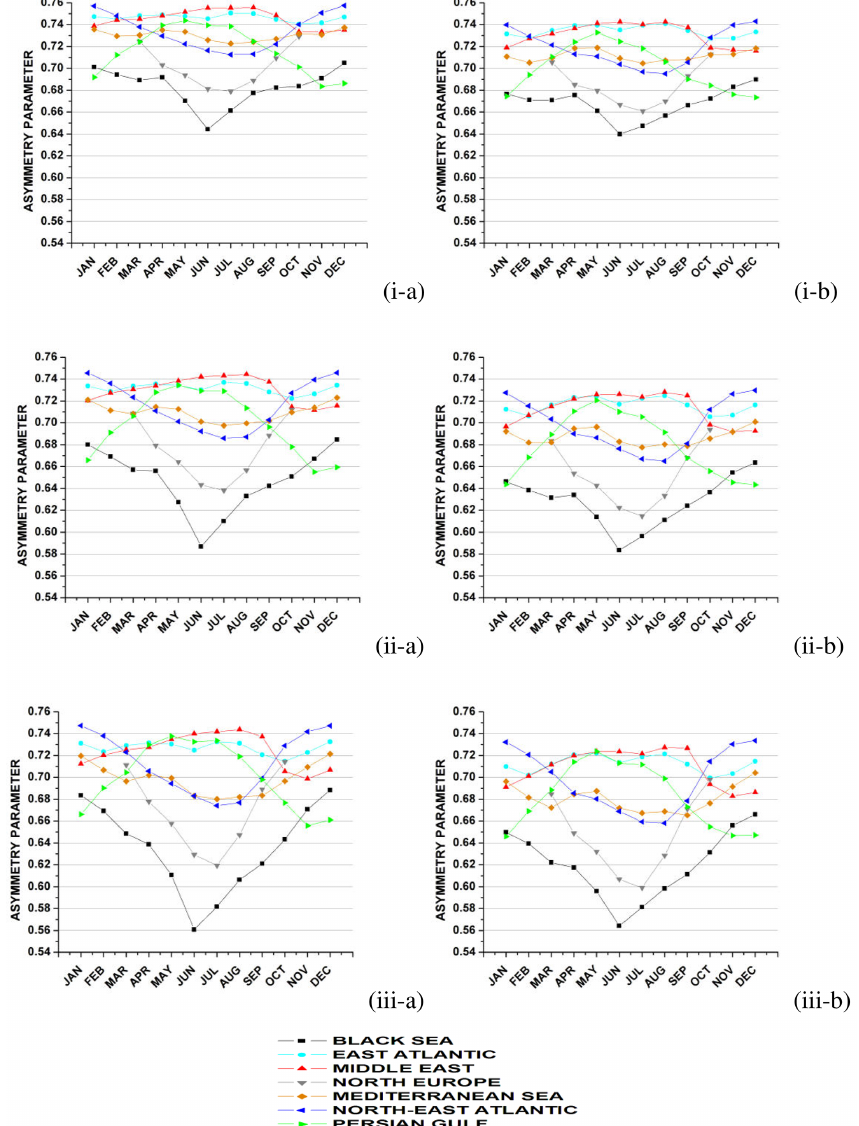
Figure 4. Intra-annual variation of MODIS, Terra ( -a , left column) and Aqua ( -b , right column), g aer values averaged over seven selected sub-regions (Fig. 1). Results are given for g aer values at 470nm ( i- , top row), 660nm ( ii- , middle row) and 860nm ( iii- , bottom row), averaged over the period 2002–2010,